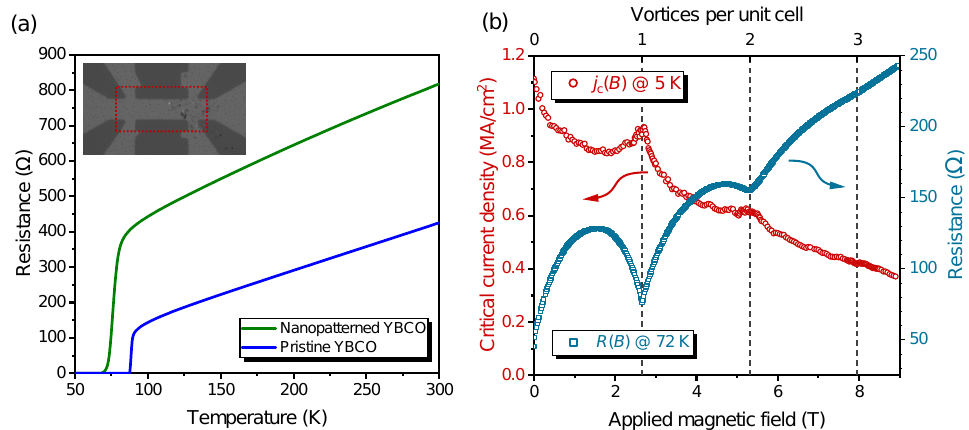
Figure 1. ( a ) Resistances of a YBCO thin film with a hexagonal array of 30 nm spaced columnar defects and an unirradiated reference bridge fabricated on the same substrate. Inset: Optical microscopy picture of the bridge taken after irradiation. The red dotted rectangle marks the irradiated area of 36 × 16 µ m 2 . ( b ) Critical current density at 5K and resistance at 72K of the irradiated bridge. The broken lines indicate the number of vortices per unit cell of the hexagonal CD lattice, corresponding to the matching fields B m = m × 2.653T, which were calculated from Equation (5) using the nominal geometry of the irradiation